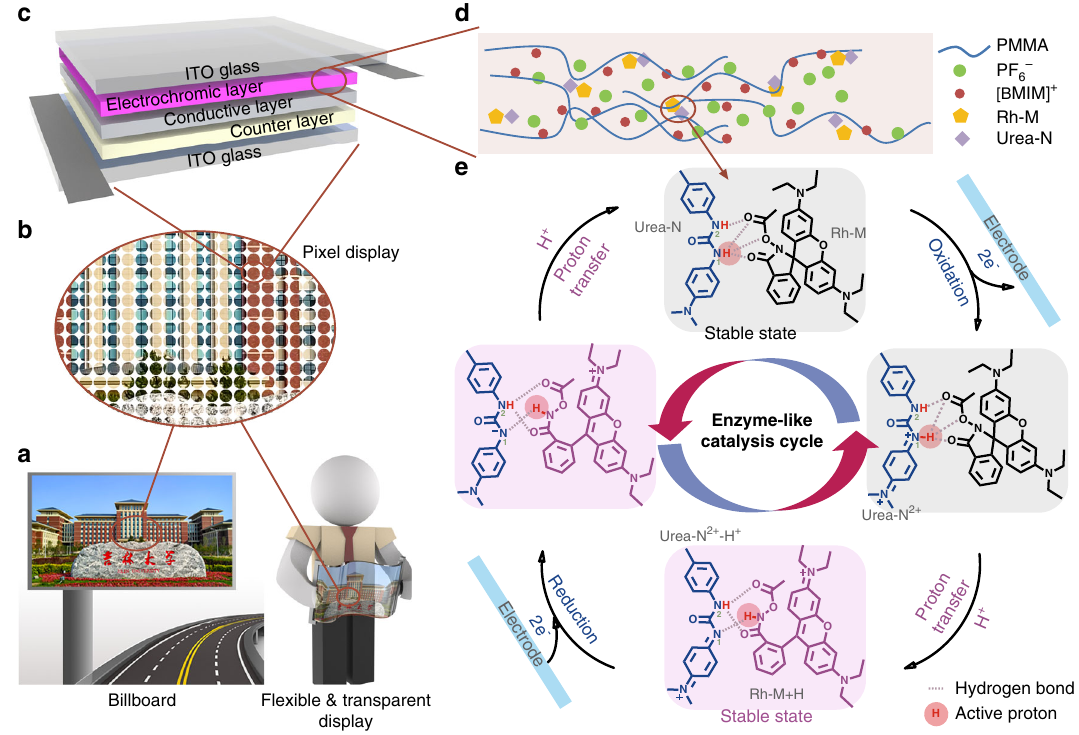
Fig. 4 Schematic diagrams and mechanism of the “ Urea-N + Rh-M ” electrochromic system. a Schematic of energy-saving billboard (left) and fl exible transparent display (right). b Schematic of pixel display. c Structure of bistable electrochromic device. d The composition of the electrochromic layer. e The proposed mechanism (gray dashed line: hydrogen bonding between Urea-N and Rh-M ; red circle: active proton that transferred between Urea-N and Rh-M